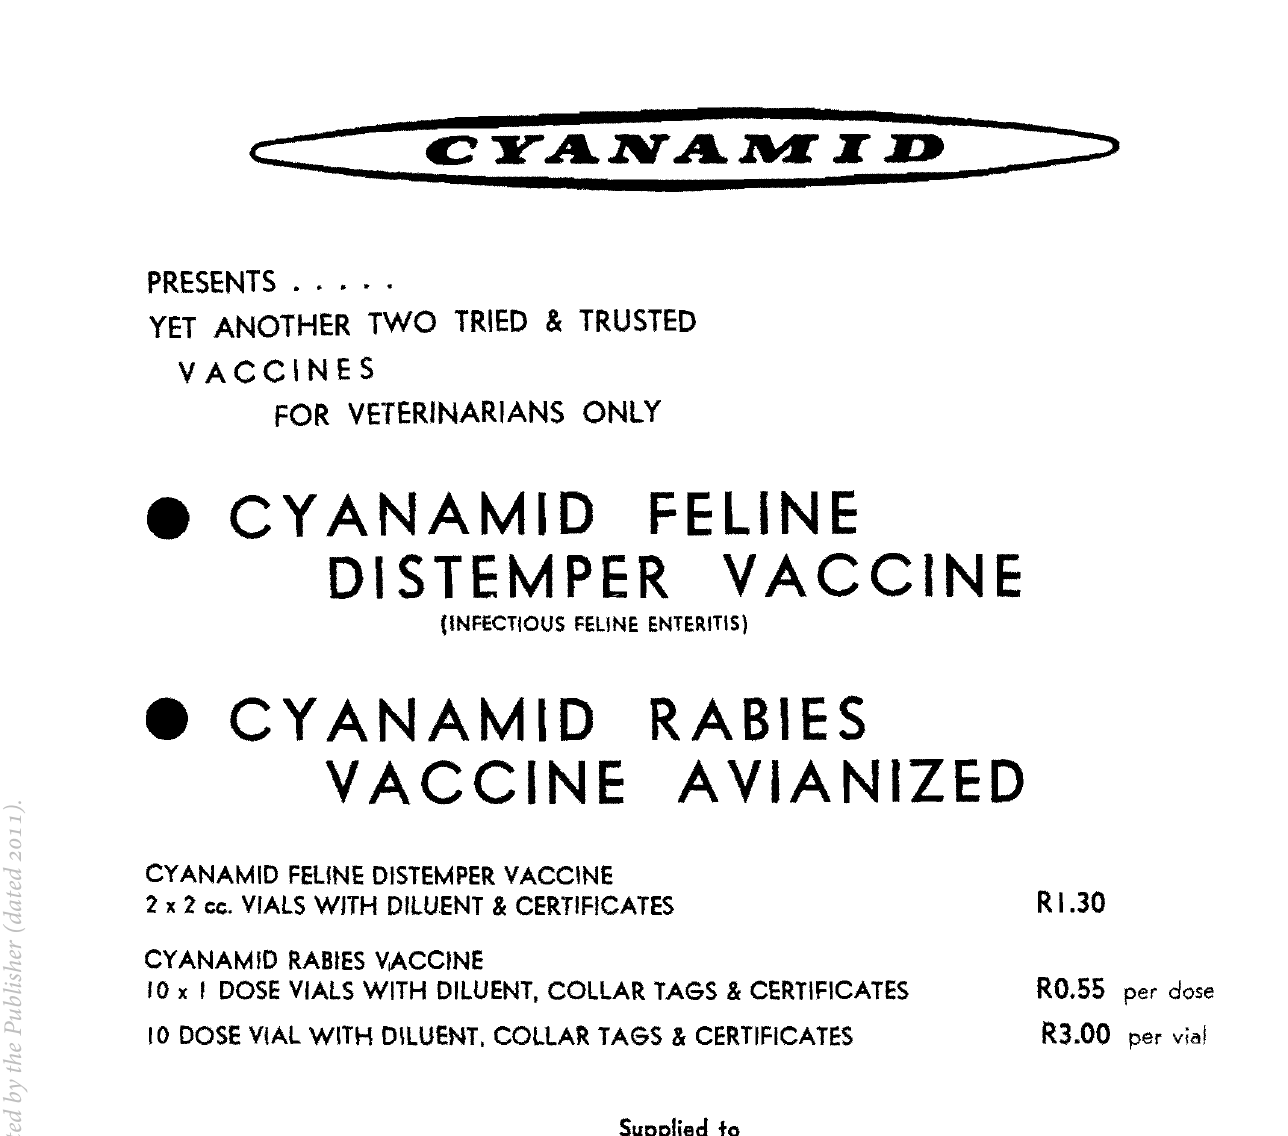
2 x 2 ceo VIALS WITH DILUENT & CERTIFICATES CYANAMID RABIES VACCINE 10 x I DOSE VIALS WITH DILUENT, COLLAR TAGS & CERTIFICATES to DOSE VIAL WITH DILUENT. COLLAR TAGS &